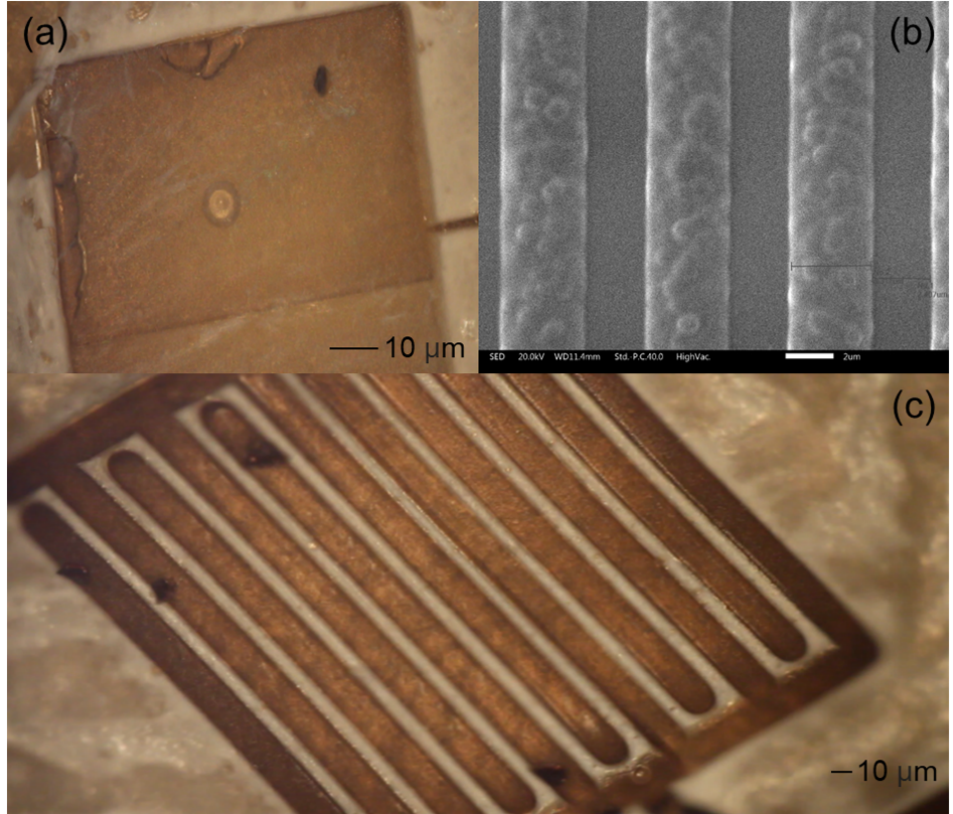
Figure 5. ( a ) Optical microscopic image of a pad structure after the final bath, i.e., Cu metallization. ( b ) SEM image of lines and spaces of 3 µ m on FR-4 using the fabrication steps. ( c ) A complex geometry achieved using the SBU-CBM fabrication method